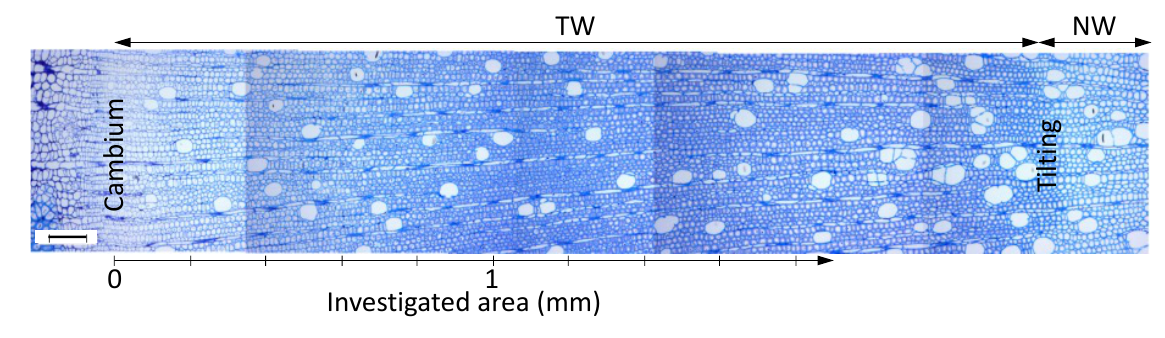
Figure 1 : optical image of the transverse section of the wood sample (Richardson’s staining) with the tension wood (TW) area between the cambium and the normal wood (NW) produced before the tree was tilted. The reference distance from the cambium was measured approximately in the middle of the cambial zone. Vertical lines correspond to the edges of different optical images. Scale bar = 0.1